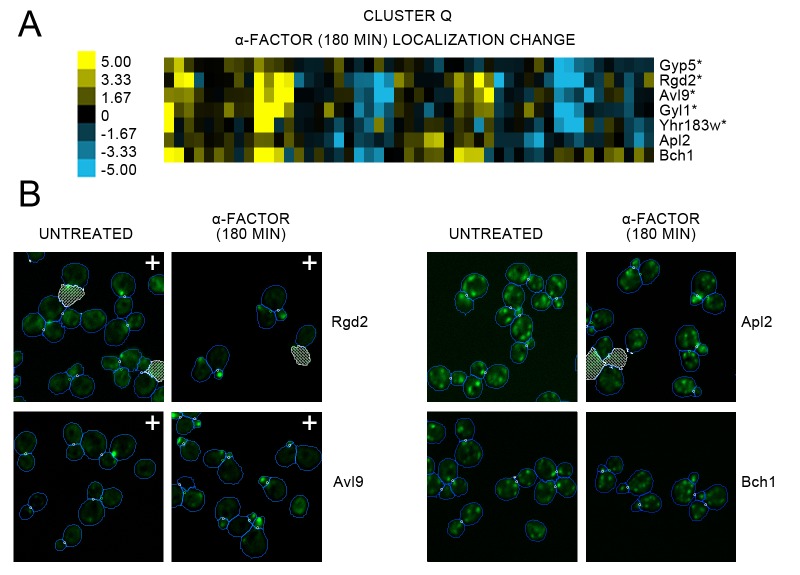
(A) Heat map of the protein localization change profiles for Cluster Q shown in Figure 2, and (B) cropped representative micrographs for some proteins in Cluster Q.For (A), we show the protein localization change profiles resulting from 180 min of alpha factor perturbation, and label the corresponding protein on the right of the heat map. The scale for the heat map is shown to the left of the heat map. Proteins for which we could confidently annotate a localization change after evaluation of the images are annotated with an asterisk (*). For (B), we show cropped micrographs of yeast cells where the labeled protein has been fused with GFP (green) for untreated cells versus 180 min of alpha factor perturbation. Cropped micrographs labelled with a plus sign (+) have had their image intensities clipped at their higher range to allow better visualization of protein localization.